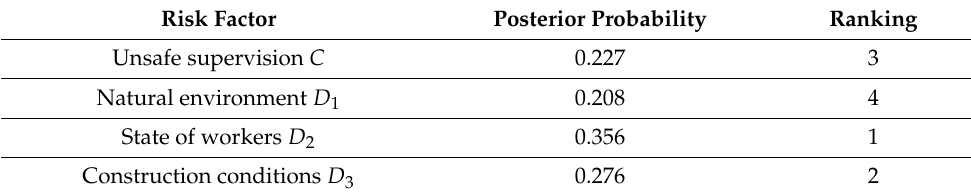
Table 8. Posterior probability of reasoning on node D.